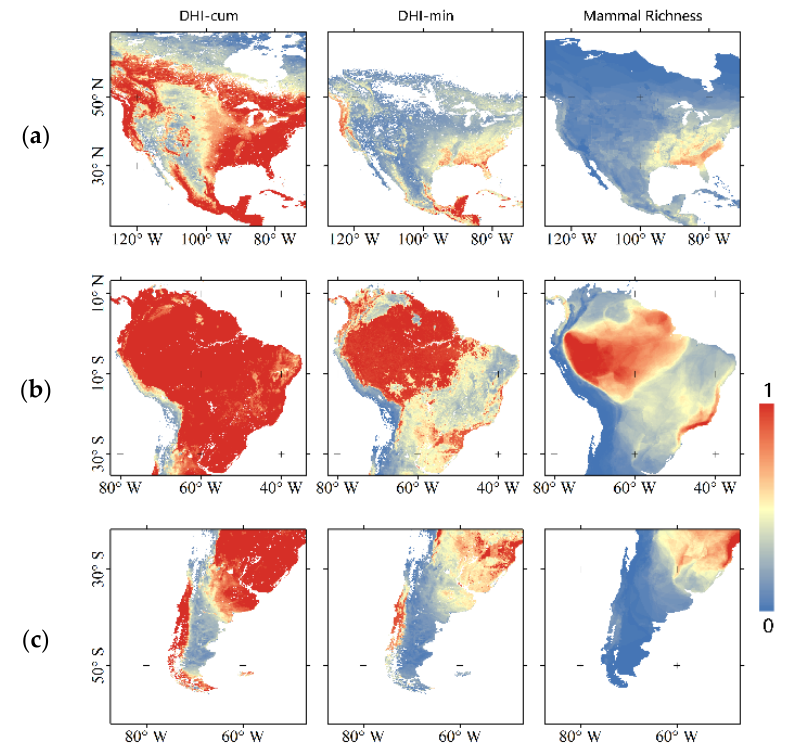
Figure 5. Geographic distribution of DHI-cum, DHI-min, mammal richness. ( a ) North America, ( b ) Argentina and Chile, ( c ) Amazon.